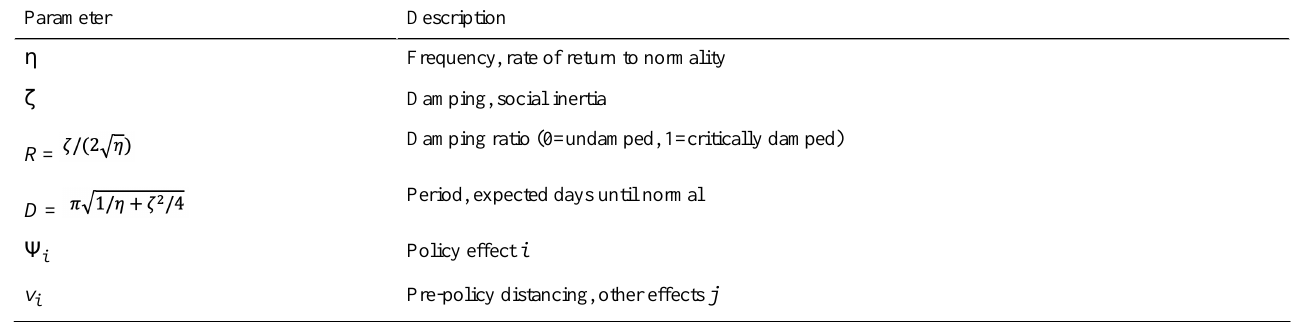
Table 1. Parameters of the